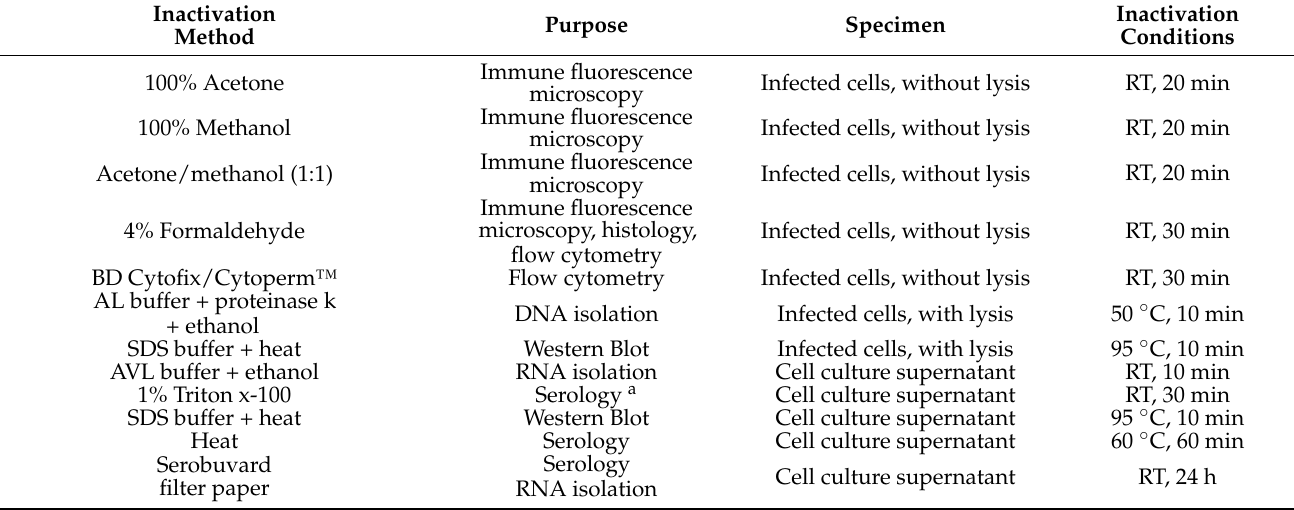
Table 1. Overview of tested inactivation